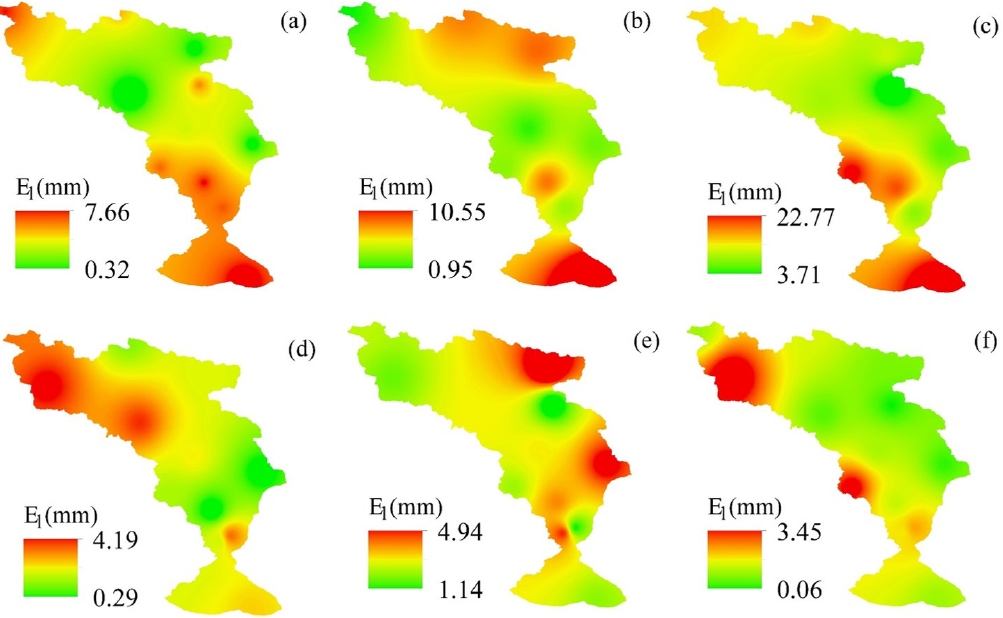
Figure 3. Spatial variation of soil fractionation ( E 1 ) values in summer 2018 ( a – c ) and 2019 ( d – f